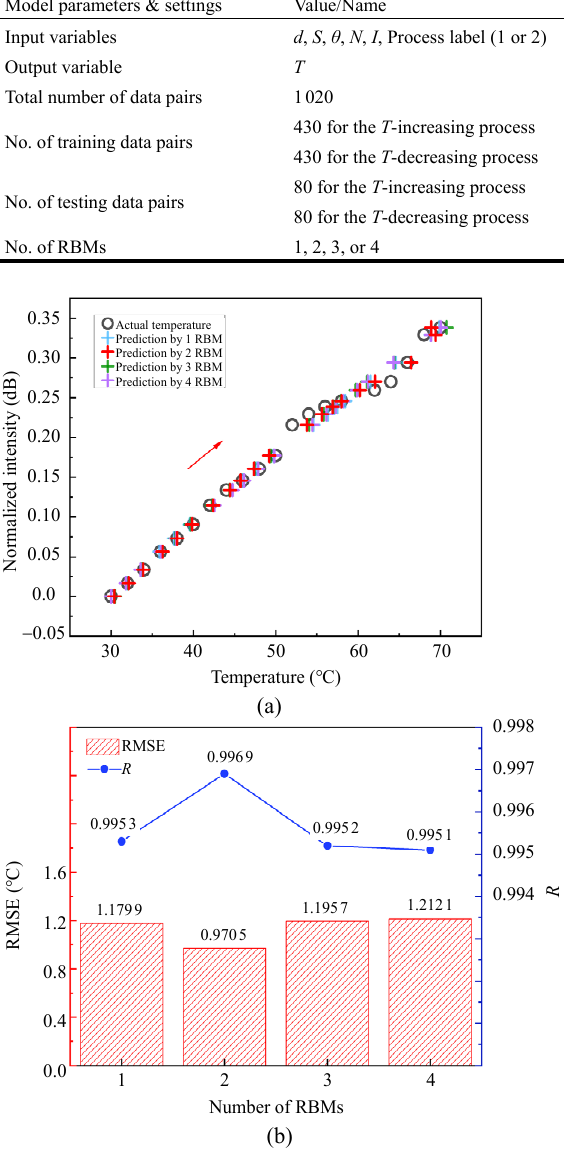
Fig. 5 Prediction skill for the temperature increasing process with DBNs of different RBM numbers: (a) response curves and (b) evaluation